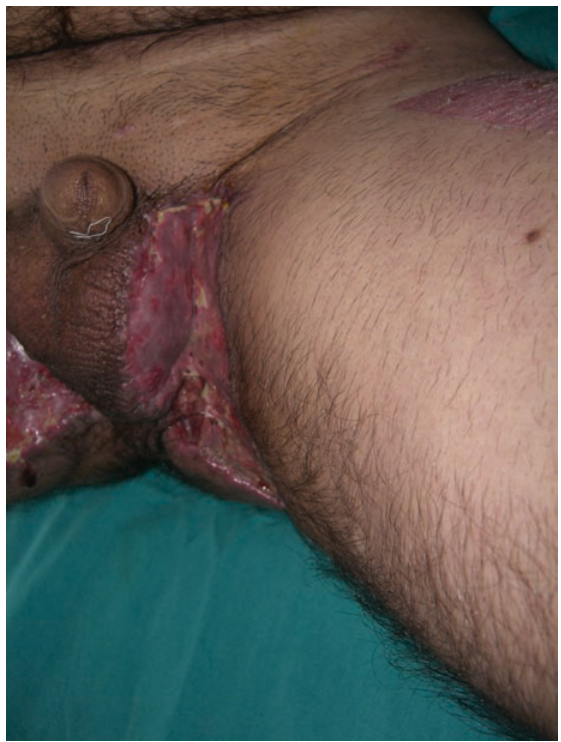
Figure 2. Reconstruction of groins with split thickness skin